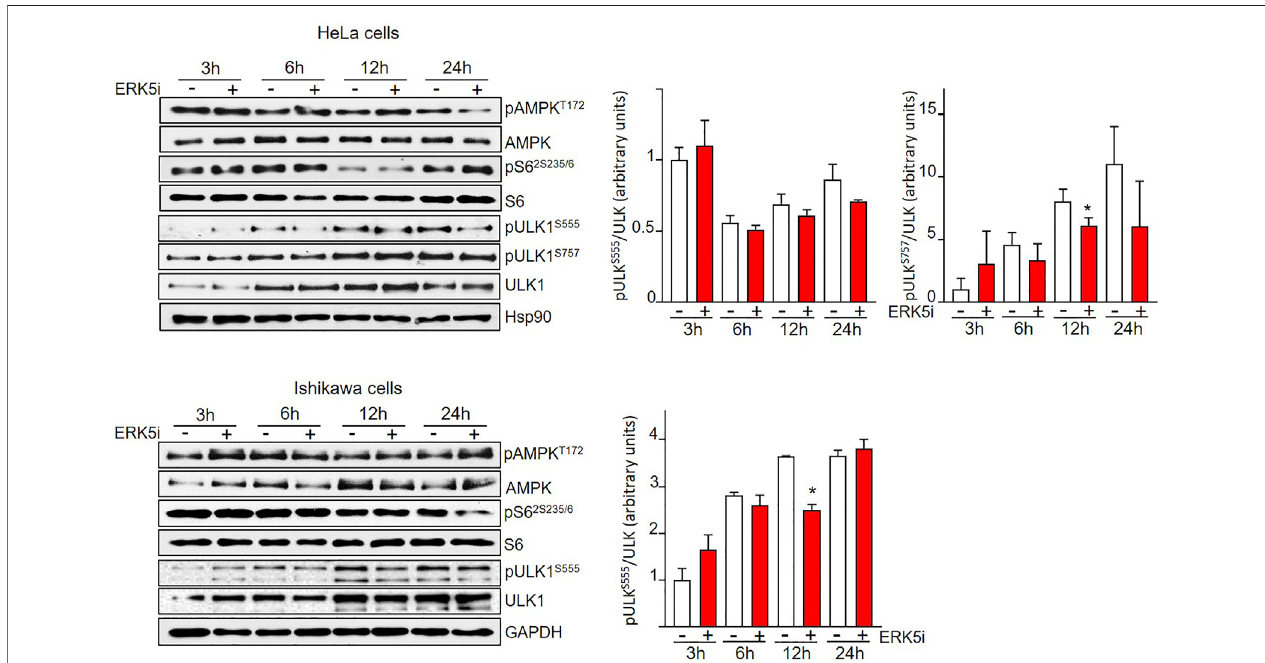
FIGURE4| ERK5inhibitioninducesautophagyindependentlyofcanonicalULKphosphorylation.HeLaandIshikawacellsweretreatedfortheindicatedtimeswith vehicle or 10 μ M JWG-071. AMPK and mTORC1 pathways were analysed by immunoblotting, using total and phosphospeci fi c antibodies (pThr172-AMPK and pSer235/236-S6).TotalULKandphospho-ULK(pSer666-ULKandpSer757-ULK)werealsoevaluatedbyimmunoblotting.GAPDHisshownasaloadingcontrol.Blots are representative of at least three separate experiments. Right histograms show the quanti fi cation of pULK Ser555 and pULK Ser555 levels, relative to total ULK, estimated by densitometry. Values represent mean ± SD of two different